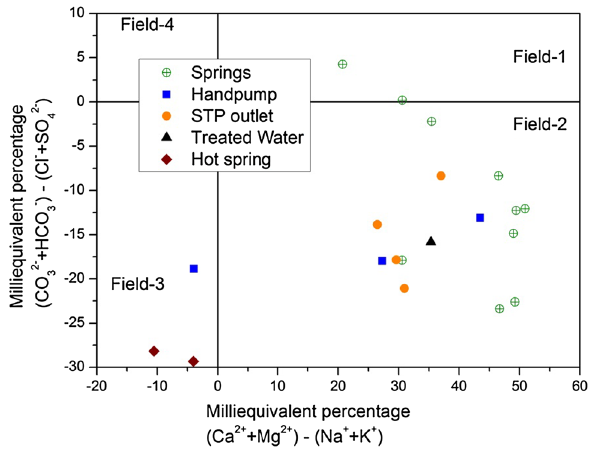
Fig. 6 Chadha’s plot of water samples highlighting the dominant hydrological processes